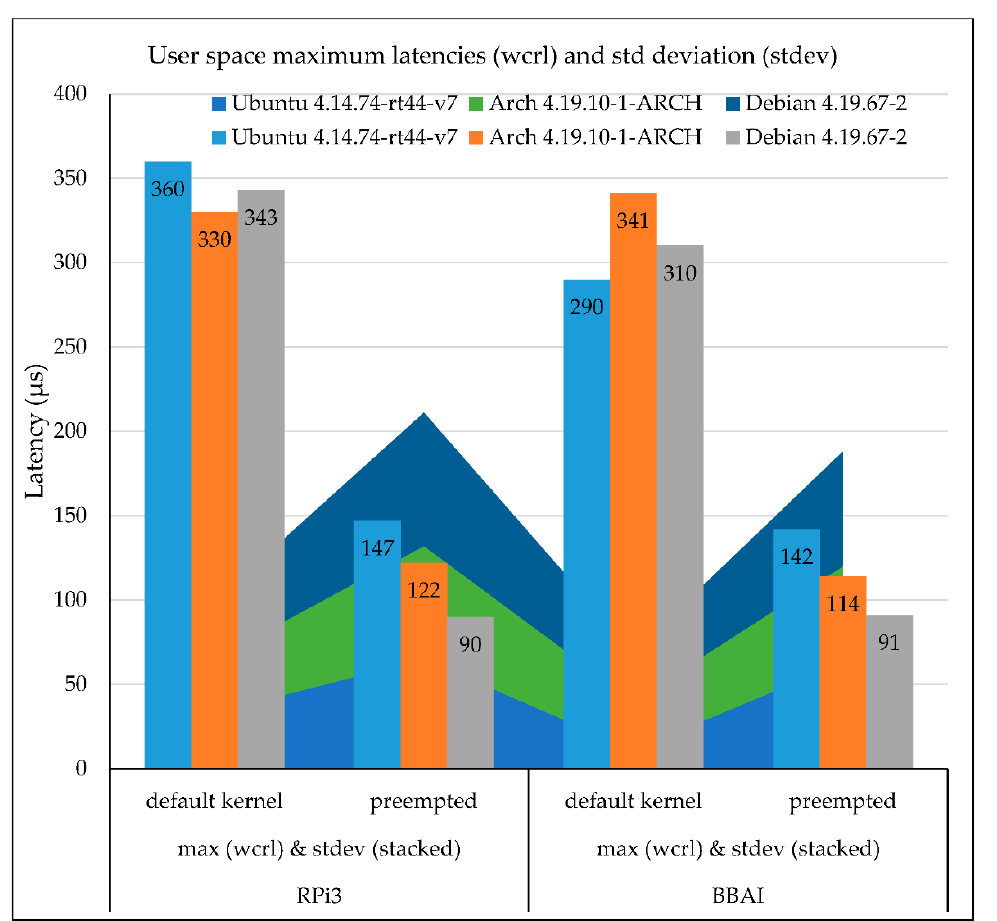
Figure 11. Maximum worst-case latencies and standard deviation for both default and preempted kernels at user space.